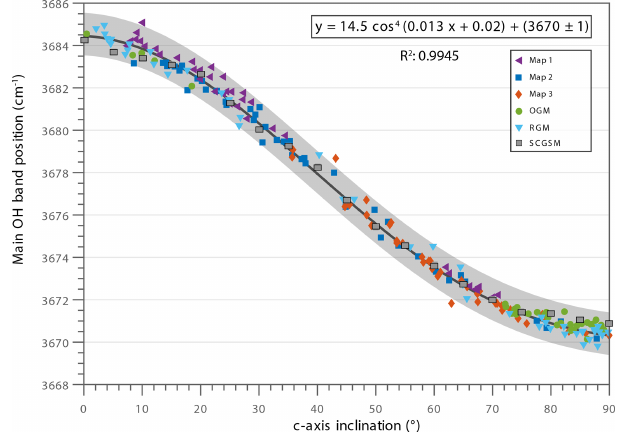
Figure 8. Position of the main band in the OH-stretching region vs. the c -axis inclination of the same grains obtained from EBSD data. The grey region shows an envelope around the data two wavenum- bers wide and can be considered a conservative estimate of the un- certainty.